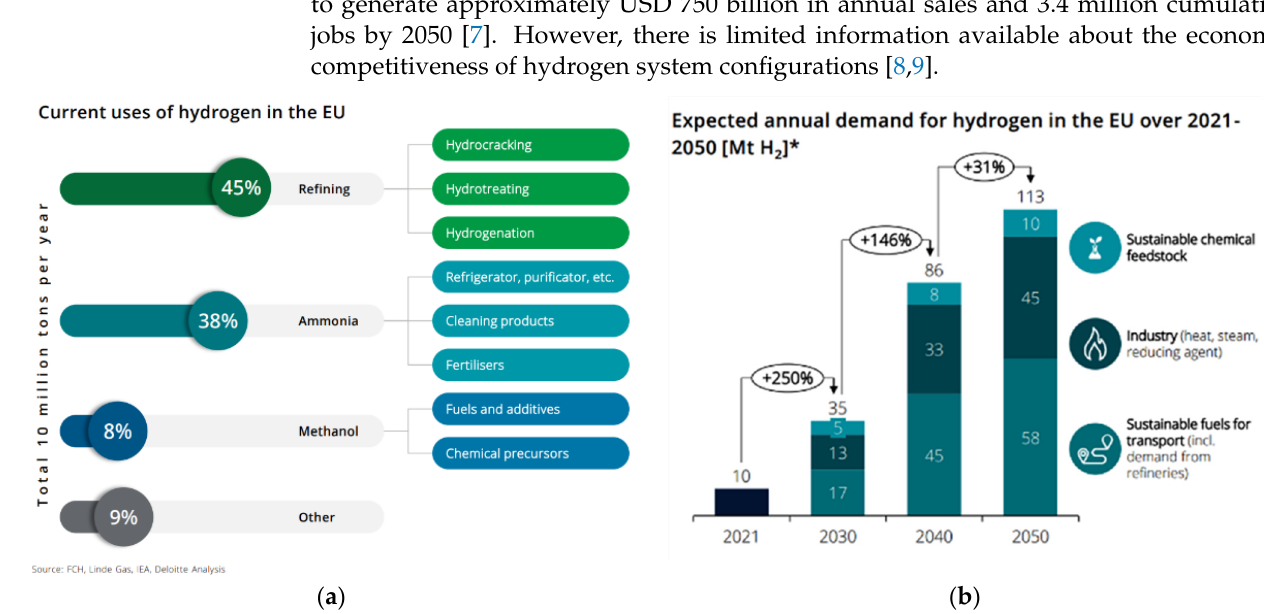
Figure 2. Hydrogen prospects of the different industrial sectors in the EU, ( a ) current usage of hydrogen, ( b ) expected hydrogen demand. * excluding potential of hydrogen in enabling renewable energy and in heating for build gas. Reprinted with permission [10].